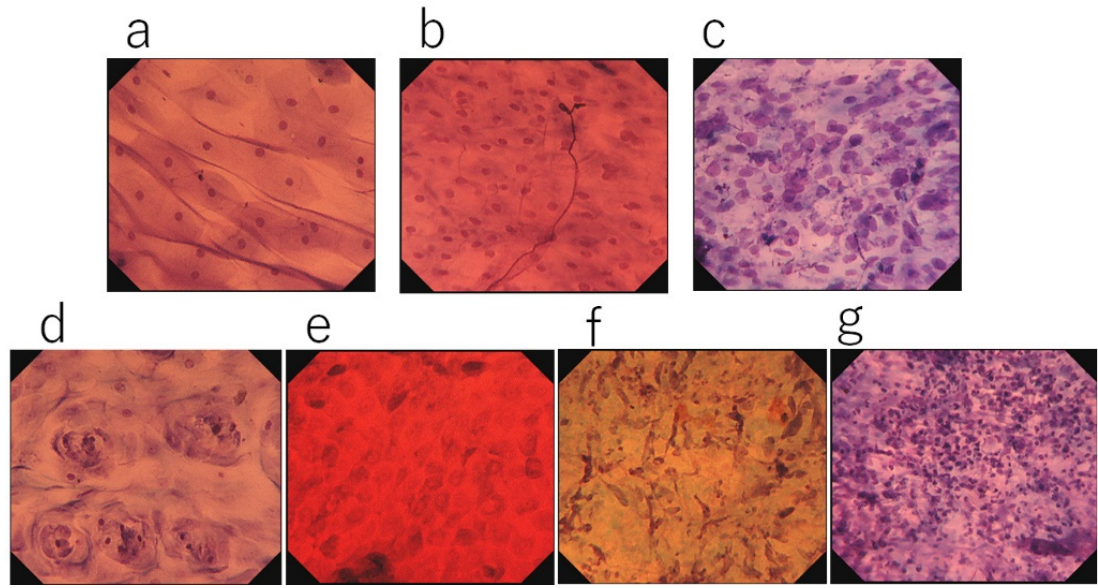
Figure 2. Type classification: ( a ) Type 1, surface epithelial cells show a low nucleus/cytoplasm (N/C) ratio and no nuclear abnormality. Nuclear density is low or slightly increased (toluidine blue staining, × 900). ( b ) Type 2, evident increase in nuclear density. Slight nuclear abnormality is evident, but not sufficiently obvious to be considered type 3 (toluidine blue staining, × 900). ( c ) Type 3, evidently increased nuclear density and nuclear abnormality, e.g., irregular nuclear size and shape, with hyperchromatism (toluidine blue staining, × 900). ( d ) Non-malignant EC feature 1 (GERD): circularly arranged squamous cells without nuclear abnormality around epithelial papillae (toluidine blue staining, × 900). ( e ) Non-malignant EC feature 2 (regenerative squamous epithelium): evident increase in nuclear density with differing nuclear sizes and shapes. Densely stained cytoplasm with a clear cell border. Nuclei are stained weakly, and multiple nucleoli are evident (toluidine blue staining, × 900). ( f ) Non-malignant EC feature 3 (erosion, granulation): increase in nuclear density with spindle-shaped enlarged nuclei (enlarged fibroblasts in the stroma, toluidine blue staining, × 900). ( g ) Non-malignant EC feature 4 (white coat): evident aggregation of inflammatory cells (toluidine blue staining, ×500).